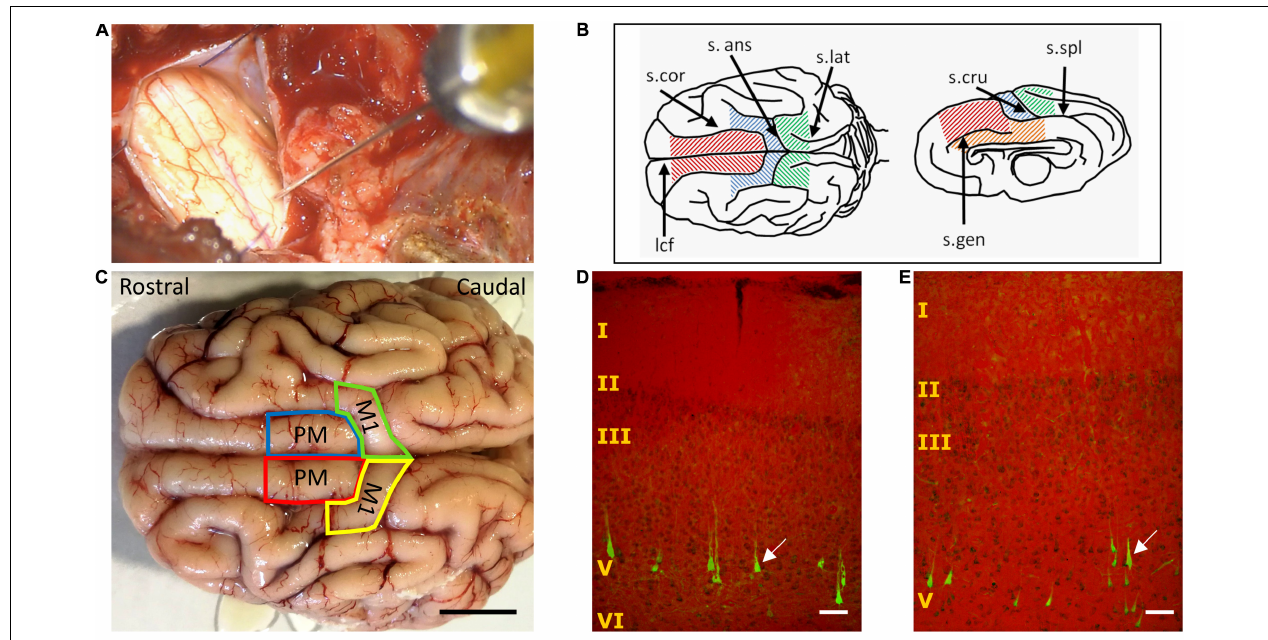
FIGURE 1 | Retrograde tracing of corticospinal neurons (CSNs). (A) Intraoperative photograph of retrograde tracer microinjection in the caudal, mid-lateral region of the C1 spinal cord segment. (B) Drawing of Sus Scrofa Domestica telencephalon showing the regions analyzed in search of retrogradely-labeled CSNs. Frontal superior gyrus, red; cruciate gyrus, blue; rostral striate cortex, green; cingulate cortex, orange. s.cor , coronal sulcus; s.ans , ansate sulcus; s.lat , lateral sulcus; lcf , longitudinal cerebral fissure; s.cru , cruciate sulcus; s.spl , splenial sulcus; s.gen , genual sulcus. (C) Dorsal aspect of the pig cerebral cortex, delineating the areas in which retrogradely-labeled CSNs were found, namely the putative premotor cortex (PM) and primary motor cortex (M1). Scale bar, 1 cm. (D,E) Illustrations of CSNs labeled in layer V of M1 (D) and PM (E) , generated by merging transmitted light (for visualizing Cresyl violet) and fluorescence images (for aminostilbamidine), captured using a 10X objective for including most of the cerebral cortex in the field view. The arrows signal typical traced neurons with pyramidal shape and apical dendrites. Scale bar, 100 µ